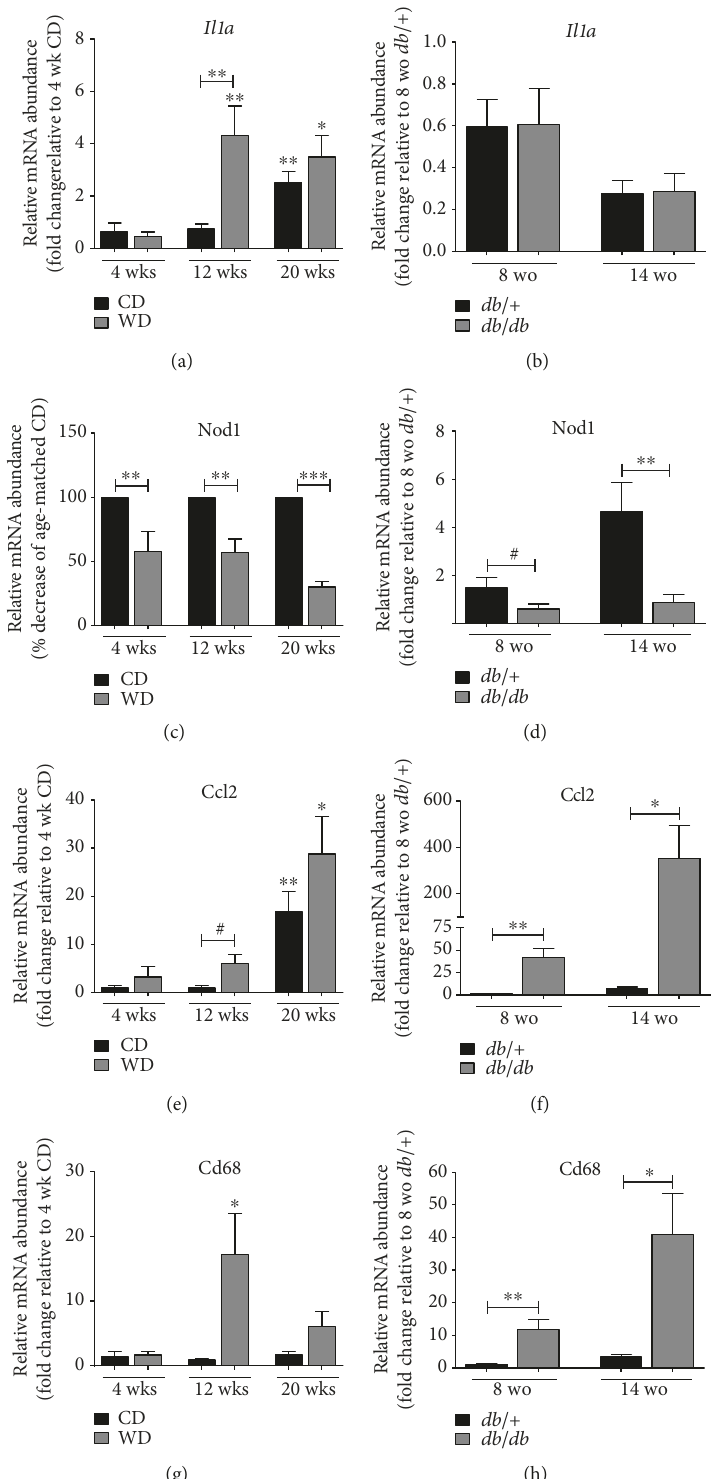
Figure 5: Increased expression of in fl ammatory markers is evident in epididymal adipose tissue from both genetic and diet-induced obesity. Relative mRNA abundance of the in fl ammatory genes Il1a (a, b), Nod1 (c, d), Ccl2 (e, f), and Cd68 (g, h) in epididymal adipose tissue from either C57BL/6J mice fed either control or Western diet for 4, 12, and 20 weeks (a, c, e, g) or 8- and 14-week-old db /+ and db/db mice (b, d, f, h). n = 8 per group. Data are normalized to the reference gene Ppia and are represented as means ± SEM. ∗∗∗ p < 0 001 ; ∗∗ p < 0 01 ; ∗ p < 0 05 ; # p < 0 1 by one-way ANOVA with Tukey ’ s post hoc analysis. (a), (e), and (g) p values versus respective 4-week dietary group unless denoted by bar. CD: control diet; WD: Western diet; wo: weeks